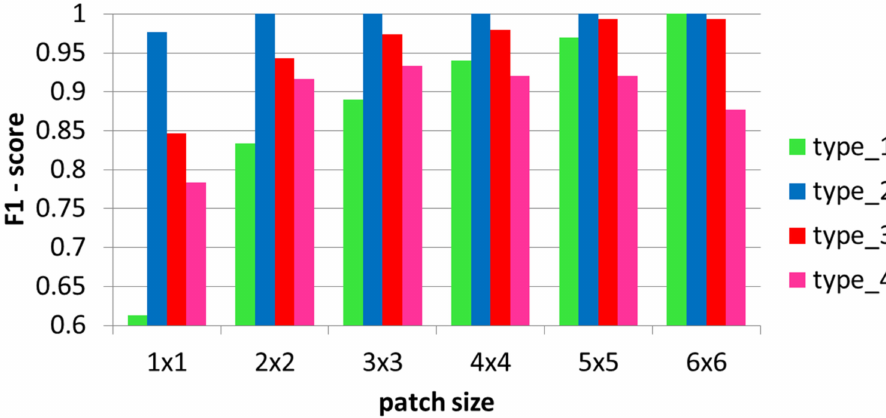
Figure 9. Bar graph of F1-scores for the different classes vs. the input patch